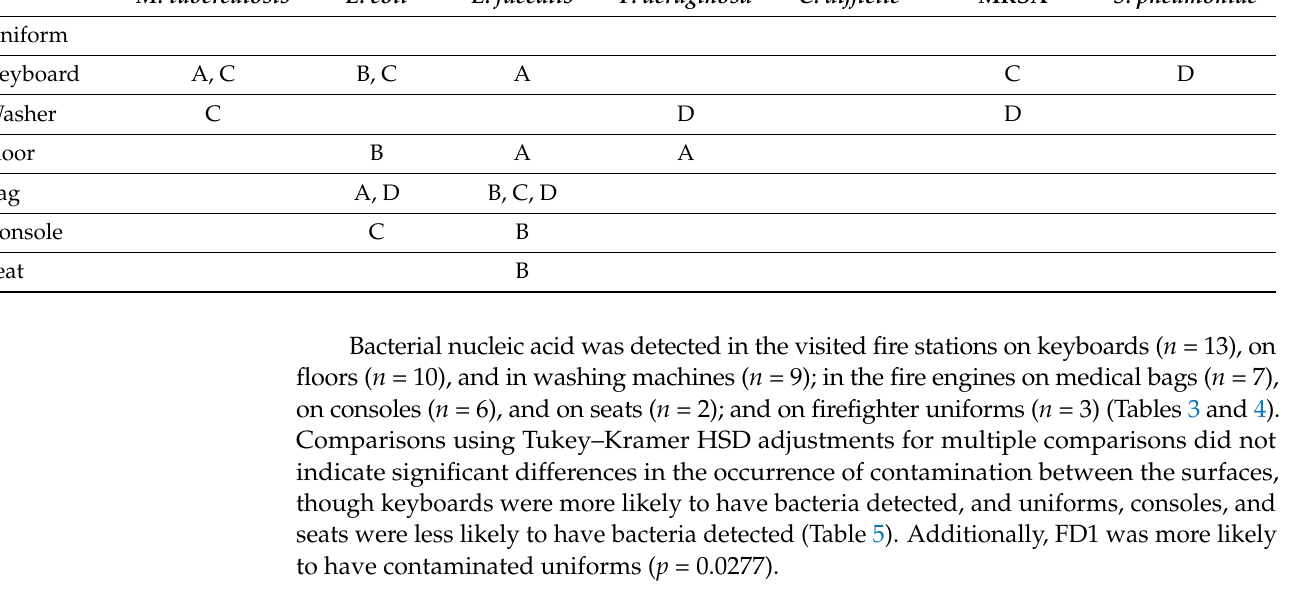
Table 4. Pathogens found on sampling sites by station location (A, B, C, D) at FD2. M. tuberculosis